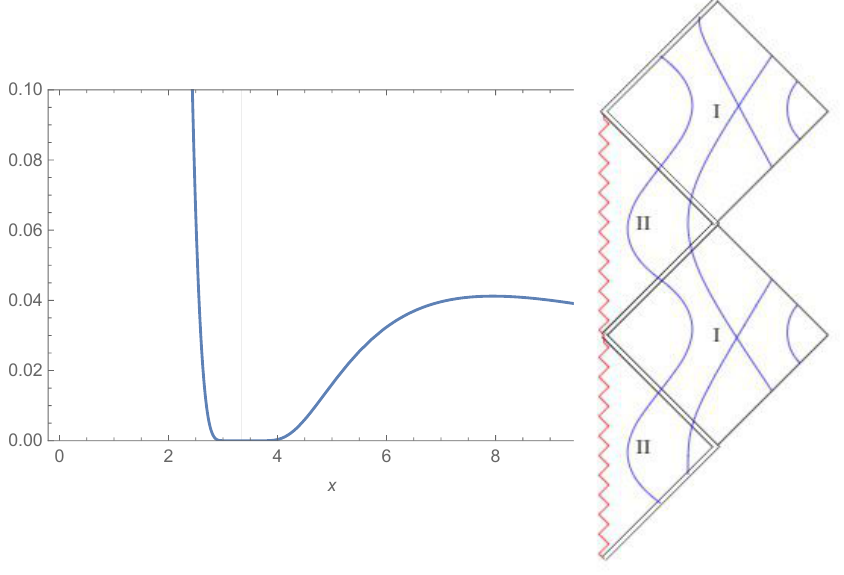
Figure 3. Plot of the effective potential for massless particles for the second solution ( left figure). The vertical line indicates the event horizon of the solution. Furthermore, the right figure is the CPD for this solution, where the red lines are the singularities, the double lines are the horizons, and the blue lines are the possible geodesic curves. For this plot, the values for the parameters were: λ = 1.5, u 0 = 0.3, and L =